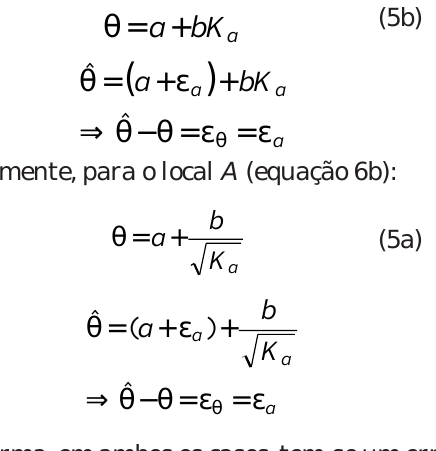
e ln(K * ) , obtidos do conjunto intacto 0 0